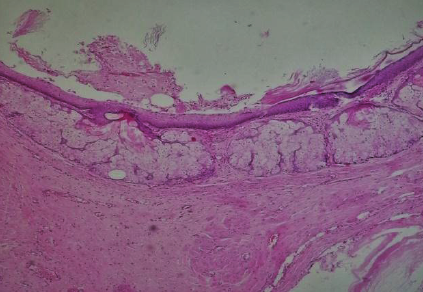
Figure 7: HE (hematoxylin and eosin) × 100 showed skin surface and sebaceous